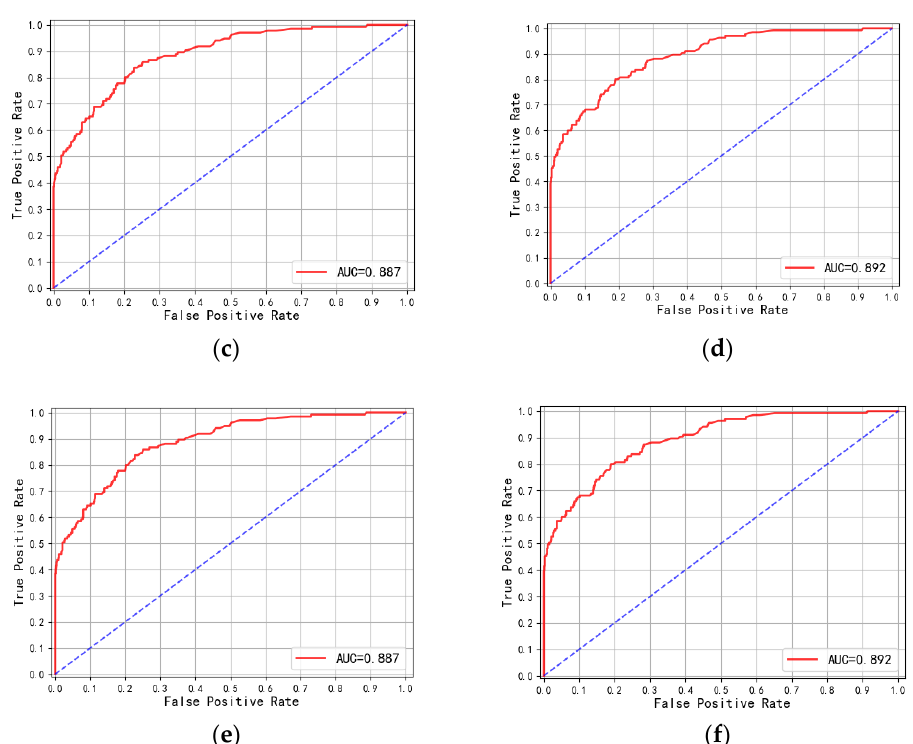
Figure 7. ROC curves and AUC values of random forest, AdaBoost, XGBoost: ( a ) gaze — random forest; ( b ) secondary driving task — random forest; ( c ) gaze — AdaBoost; ( d ) secondary driving task — AdaBoost; ( e ) gaze — XGBoost; ( f ) secondary driving task — XGBoost.